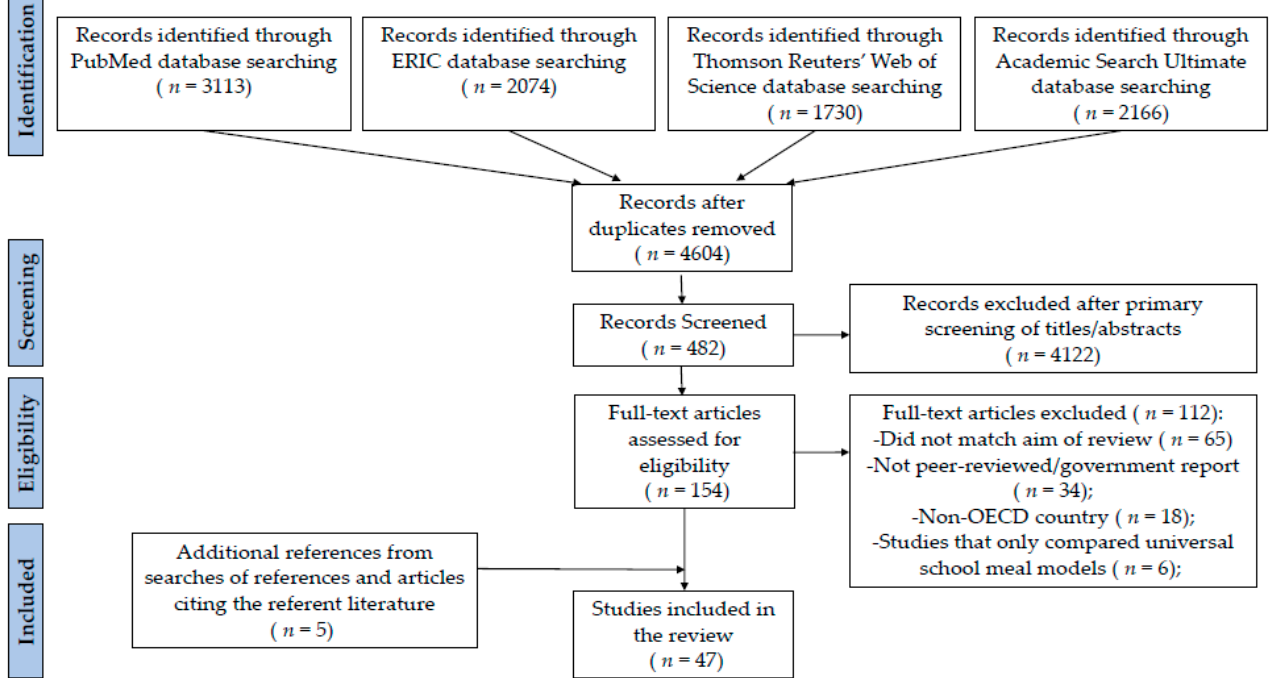
Figure 1. Flow chart for systematic review.